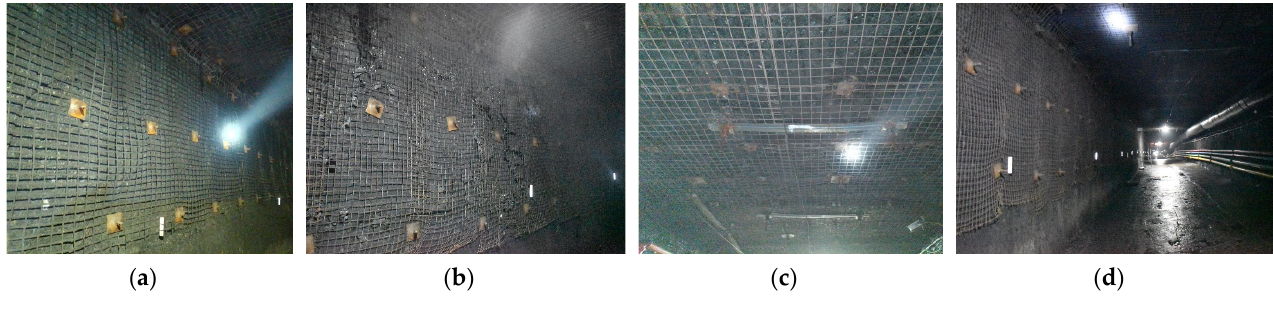
Figure 22. Maintenance effect of RAR 23205: ( a ) pillar sidewall; ( b ) pillar sidewall cracking in some places; ( c ) roof reinforcement with cable beams; ( d ) overall maintenance effect.